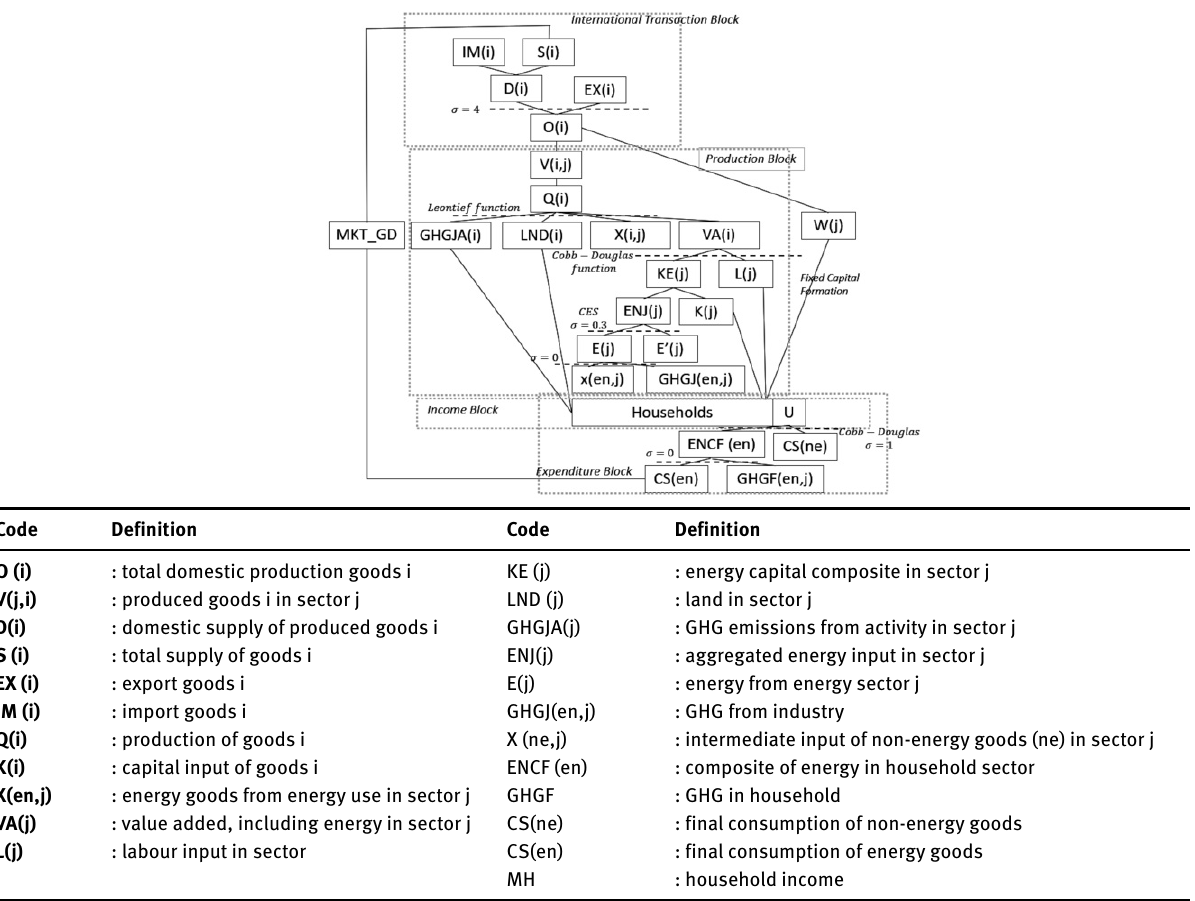
Figure 3: The relations and structure between each Sector in the CGE